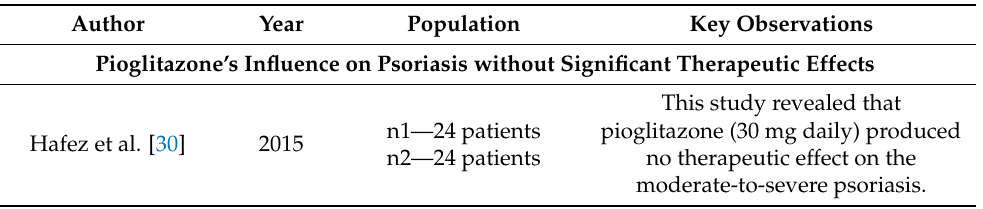
Table 11. Summary of the studies on pioglitazone’s influence on psoriasis without significant therapeutic